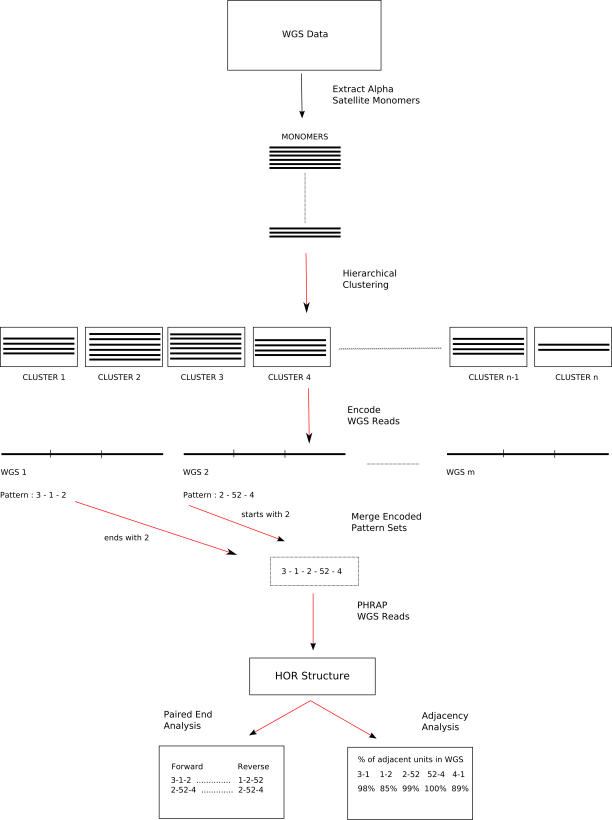
Flowchart of the HORdetect AlgorithmGiven a WGS sequence library, we first extracted alpha-satellite monomers from WGS sequence reads; performed hierarchical clustering to group highly similar monomers; encoded each WGS read with a unique cluster ID; and merged similar pattern sets. WGS sequences with the same encoded pattern set are assembled via PHRAP. The corresponding sequence (contig) is analyzed (paired-end and adjacency analysis).